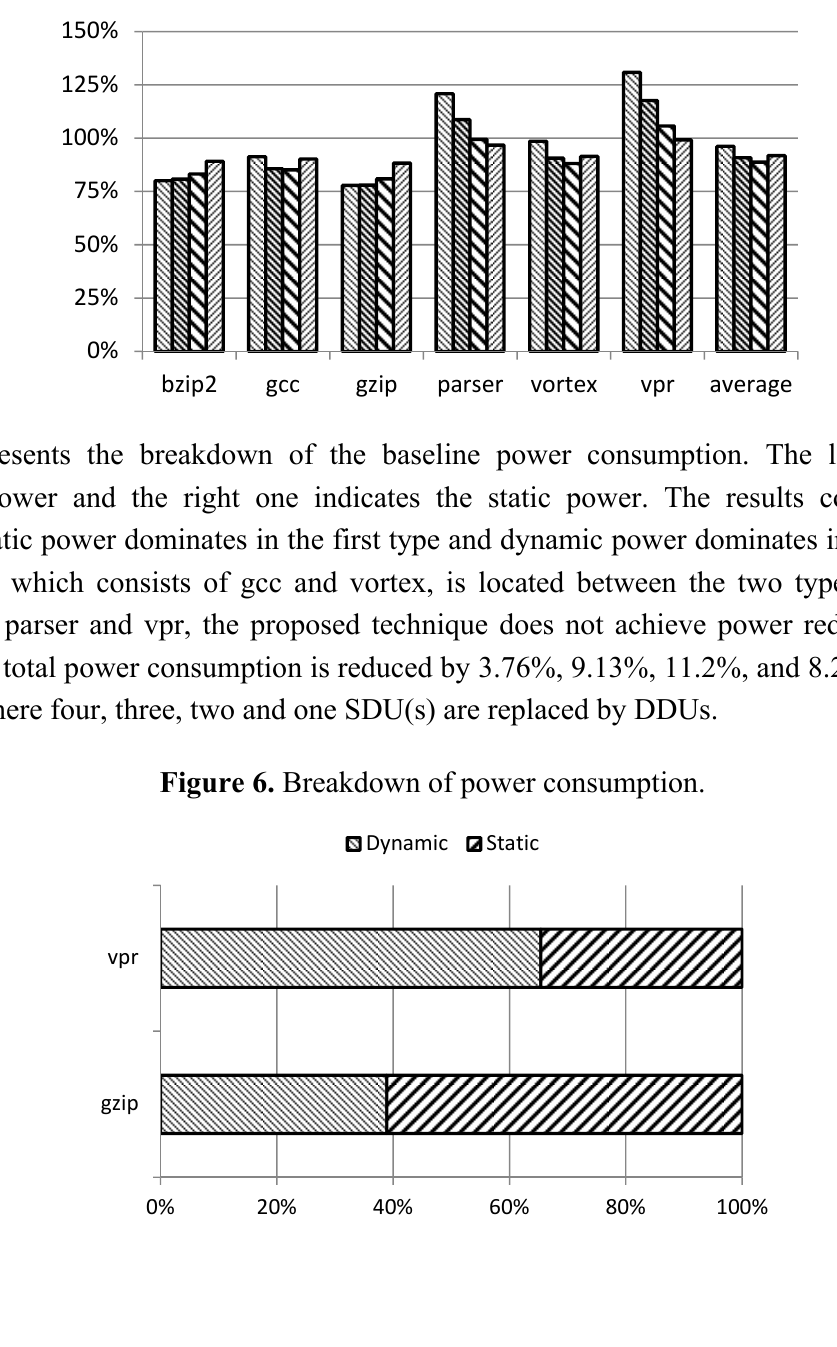
Figure 5. Relative power consumption (50%-scenario, x2.0).